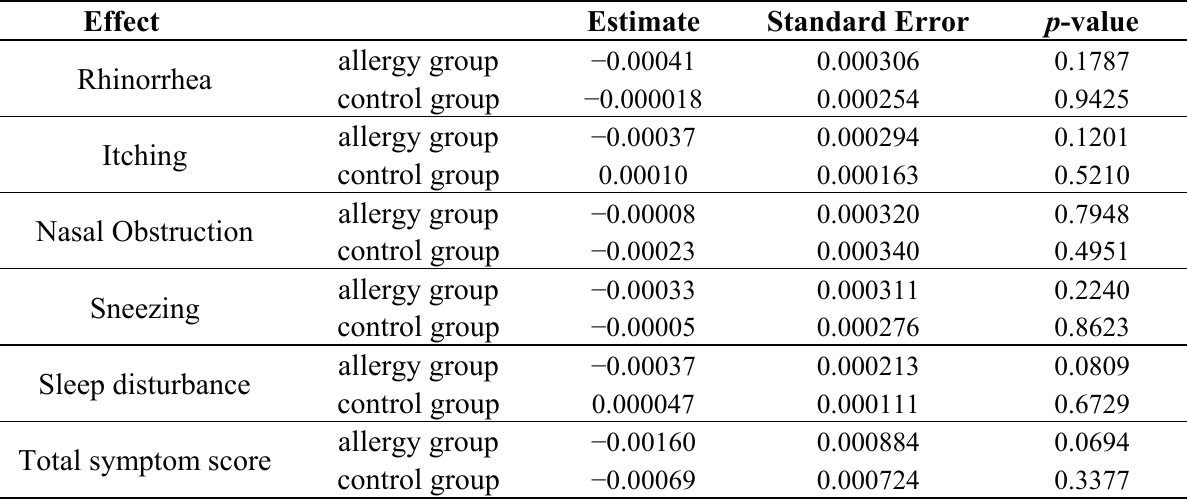
Table 4. The effects of PM 10 on allergy symptoms according to the long-term observations ( p -value).